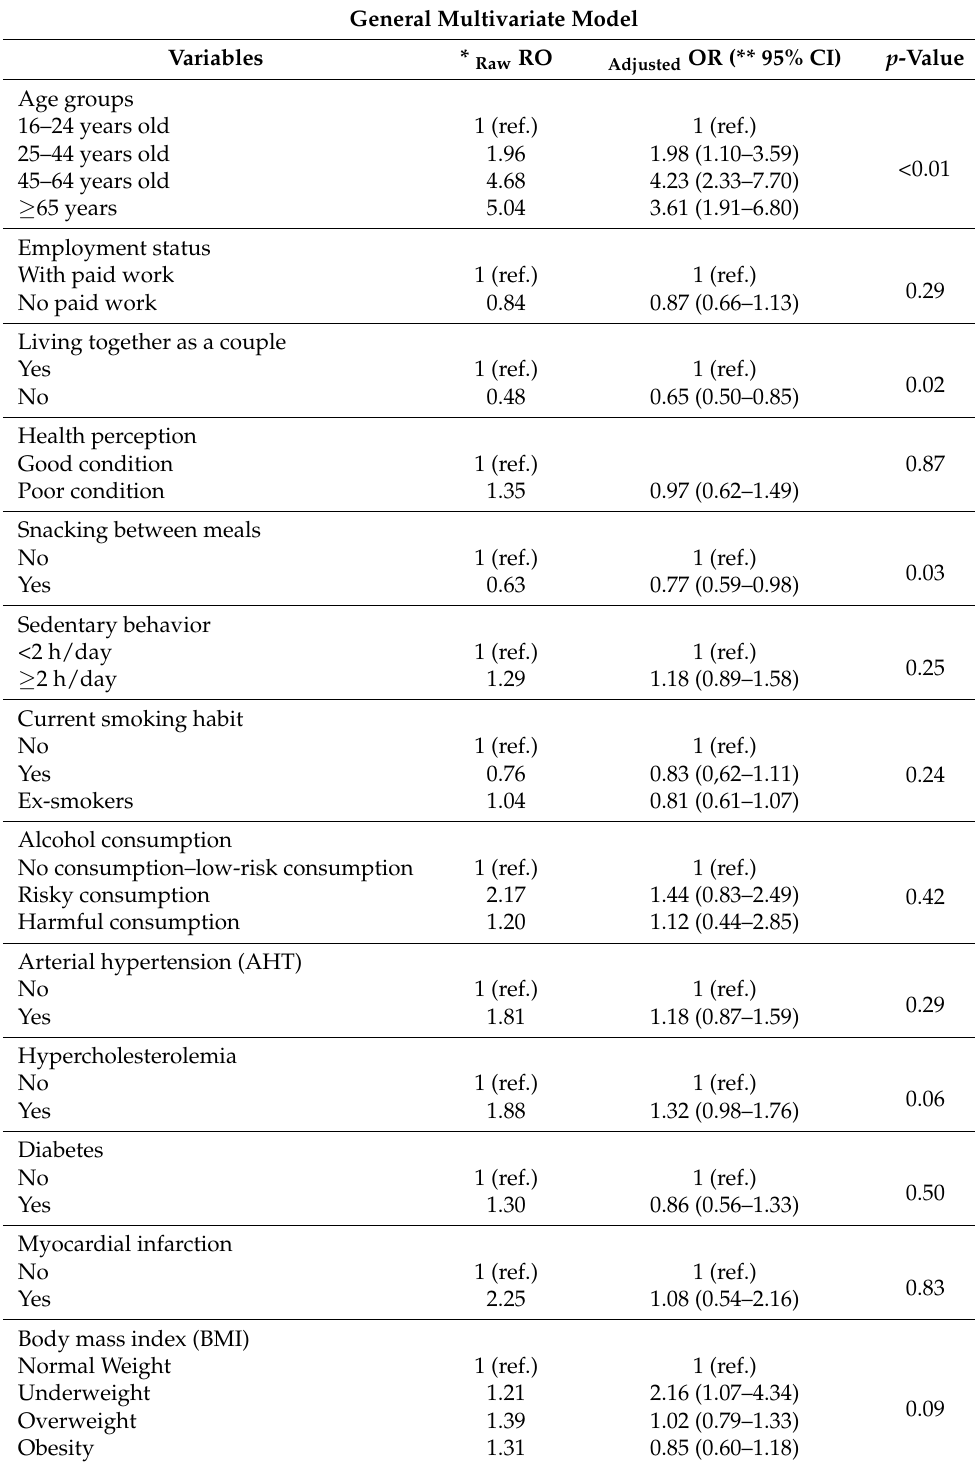
Table 5. Multivariate analysis of risk factors related to high adherence to the Mediterranean diet in the adult population of southeastern